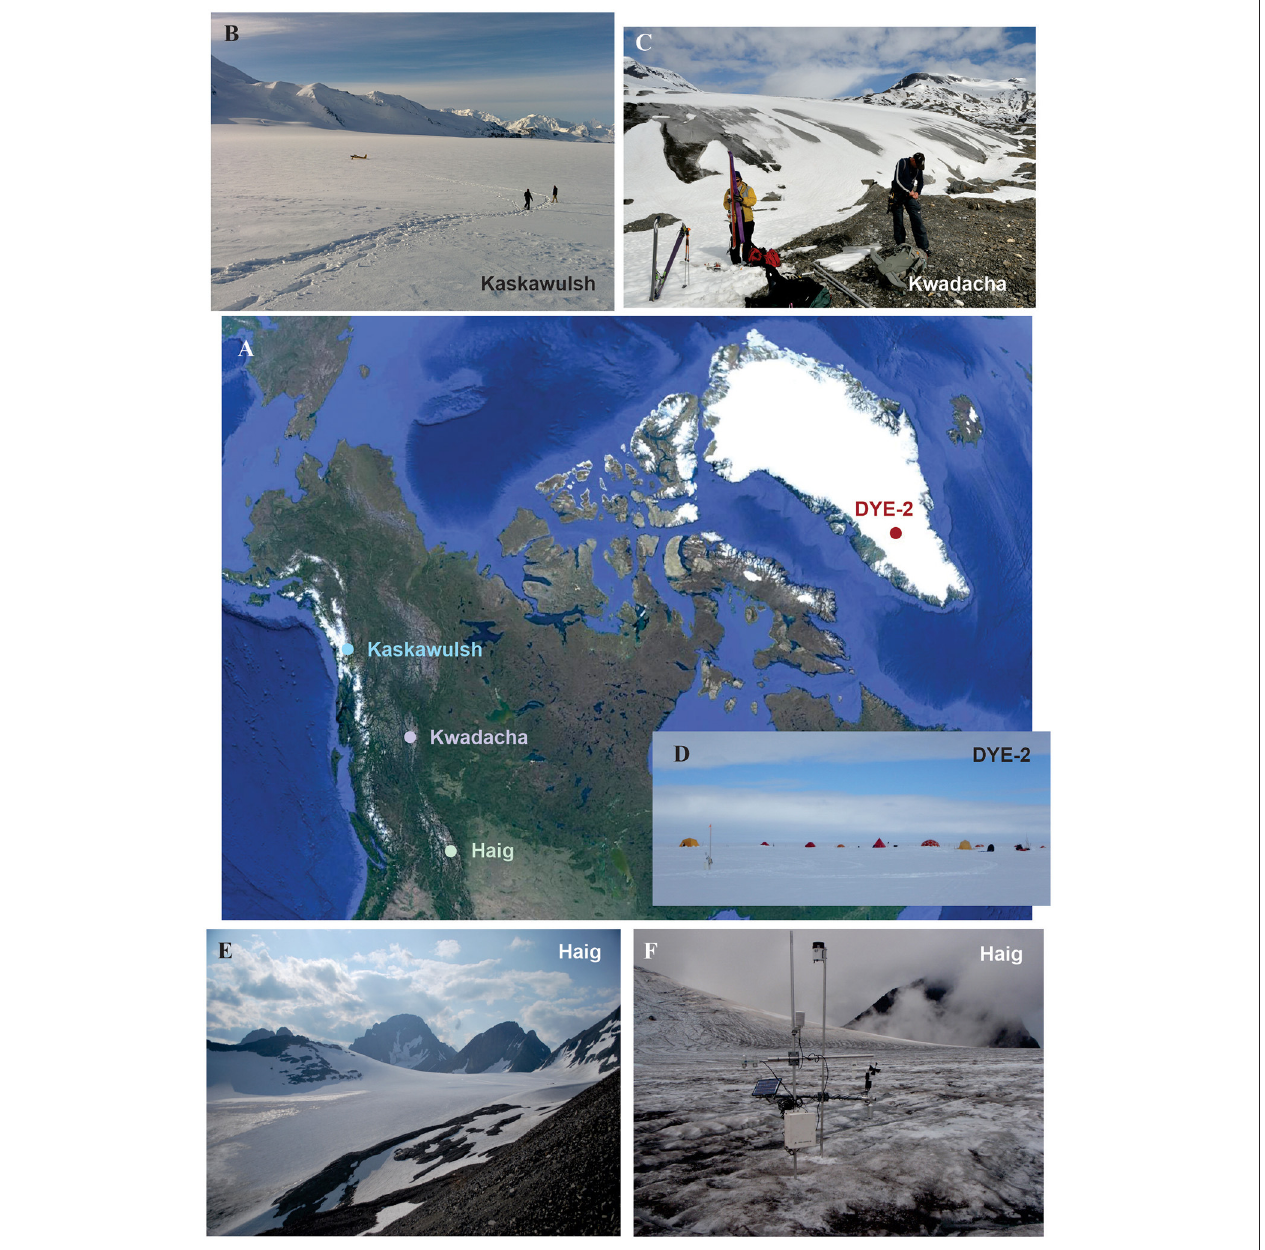
FIGURE 1 | (A) Glacier locations for data used in this study and photographs depicting the general environment of each setting: (B) Kaskawulsh Glacier, St. Elias Mountains, (C) Kwadacha Glacier, Canadian Rocky Mountains, (D) DYE-2, Greenland Ice Sheet, and (E,F) Haig Glacier, Canadian Rocky Mountains, with (F) depicting the automatic weather station on the upper glacier. Photograph (C) is courtesy of David Roberts, photograph (E) is by Chris Szymiec, and all others by the